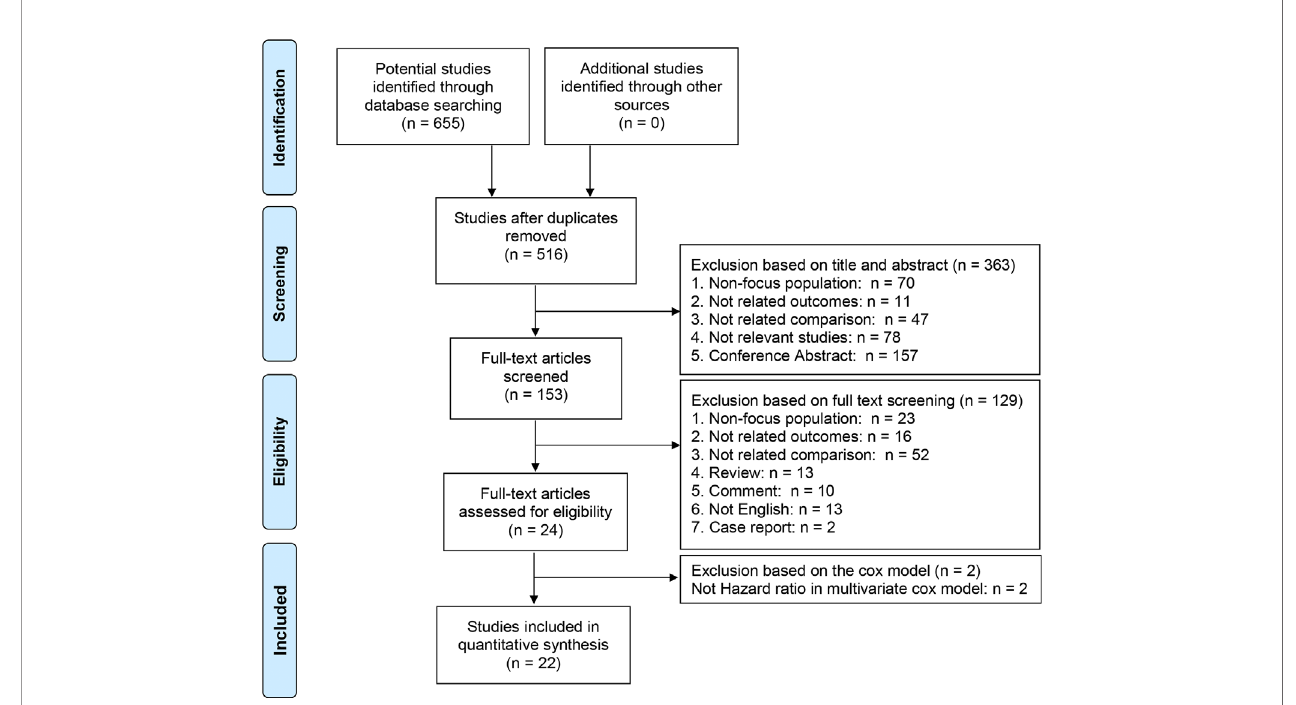
FIGURE 1 | Flow diagram of study